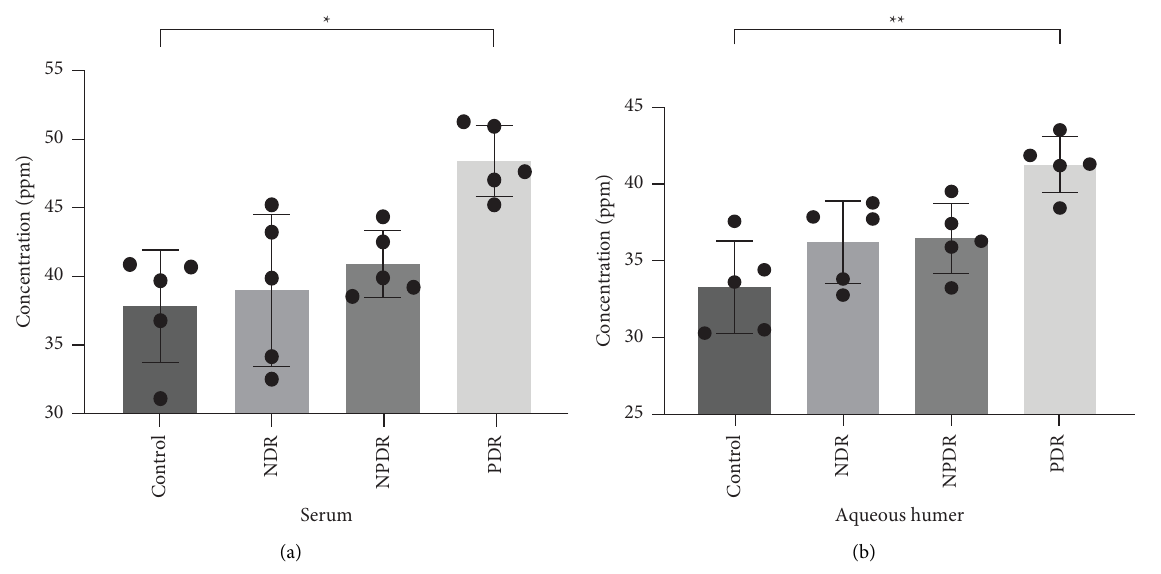
Figure 1: TMAO is present at higher concentrations in patients with proliferative diabetic retinopathy. Mean TMAO concentrations in serum (a) and aqueous humor. (b) CT: control group; NDR: non-DR group; NPDR: non-PDR group; PDR: PDR group. ∗ P vs. PDR; ∗ indicates P < 0 . 05; P values were determined using Kruskal − Wallis test as